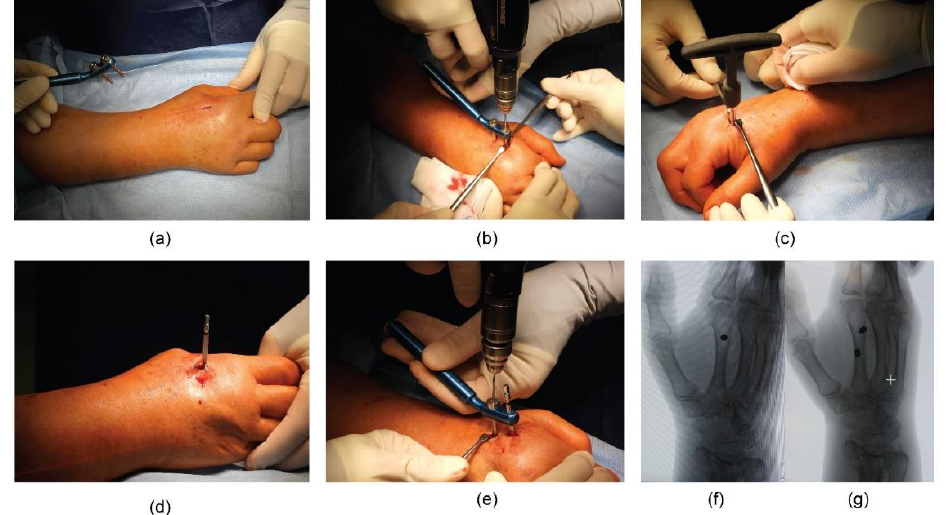
Figure 2. Intra-operative images showing: ( a ) dorsal skin incision at the base of the second metacarpal bone; ( b – d ) insertion of the first distal bicortical pin; ( e ) insertion of the second distal cortical pin using the proper tool to maintain the right distance between the pins; antero-posterior (AP) fluoroscopic control of ( f ) the first and ( g ) the second distal pin on the second metacarpal bone.